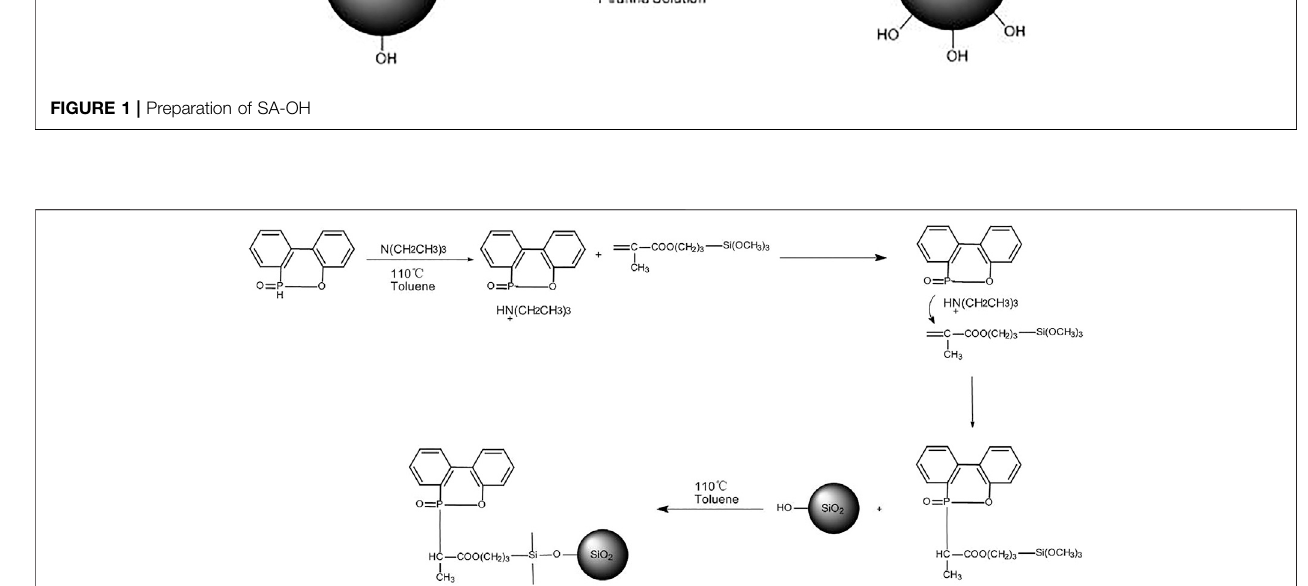
FIGURE 2 | The synthetic route of SA-g-DOPO.